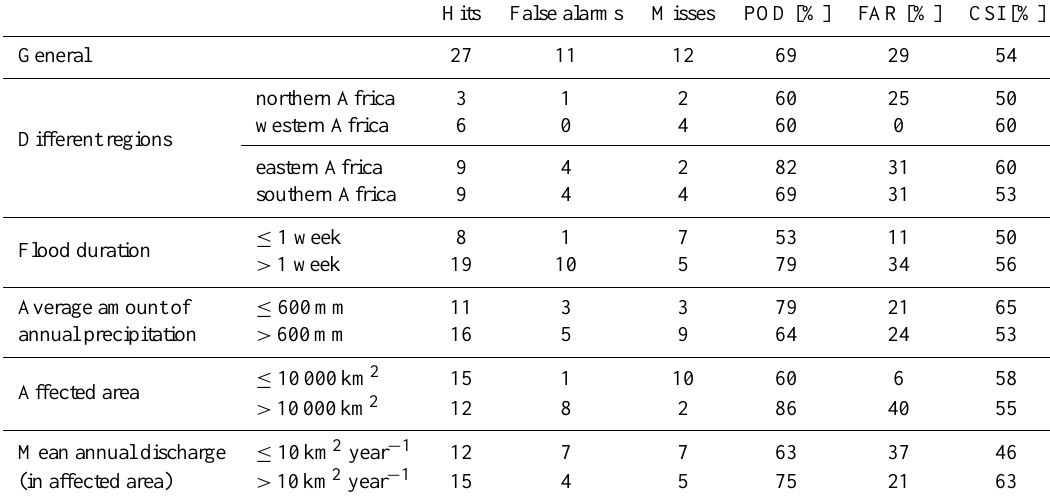
Figure 8. Limit of predictability at the selective stations; (a) with seasonal mean as the benchmark and (b) with persistence as the benchmark. Table 5. Semi-qualitative evaluation of AFFS ability to detect flood events. Hits False alarms Misses POD